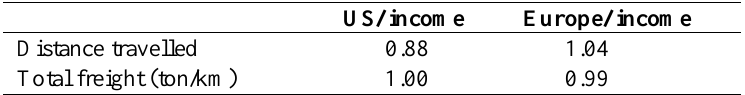
Table 8. Long term transportation demand elasticities US/ income Europe/ income Distance